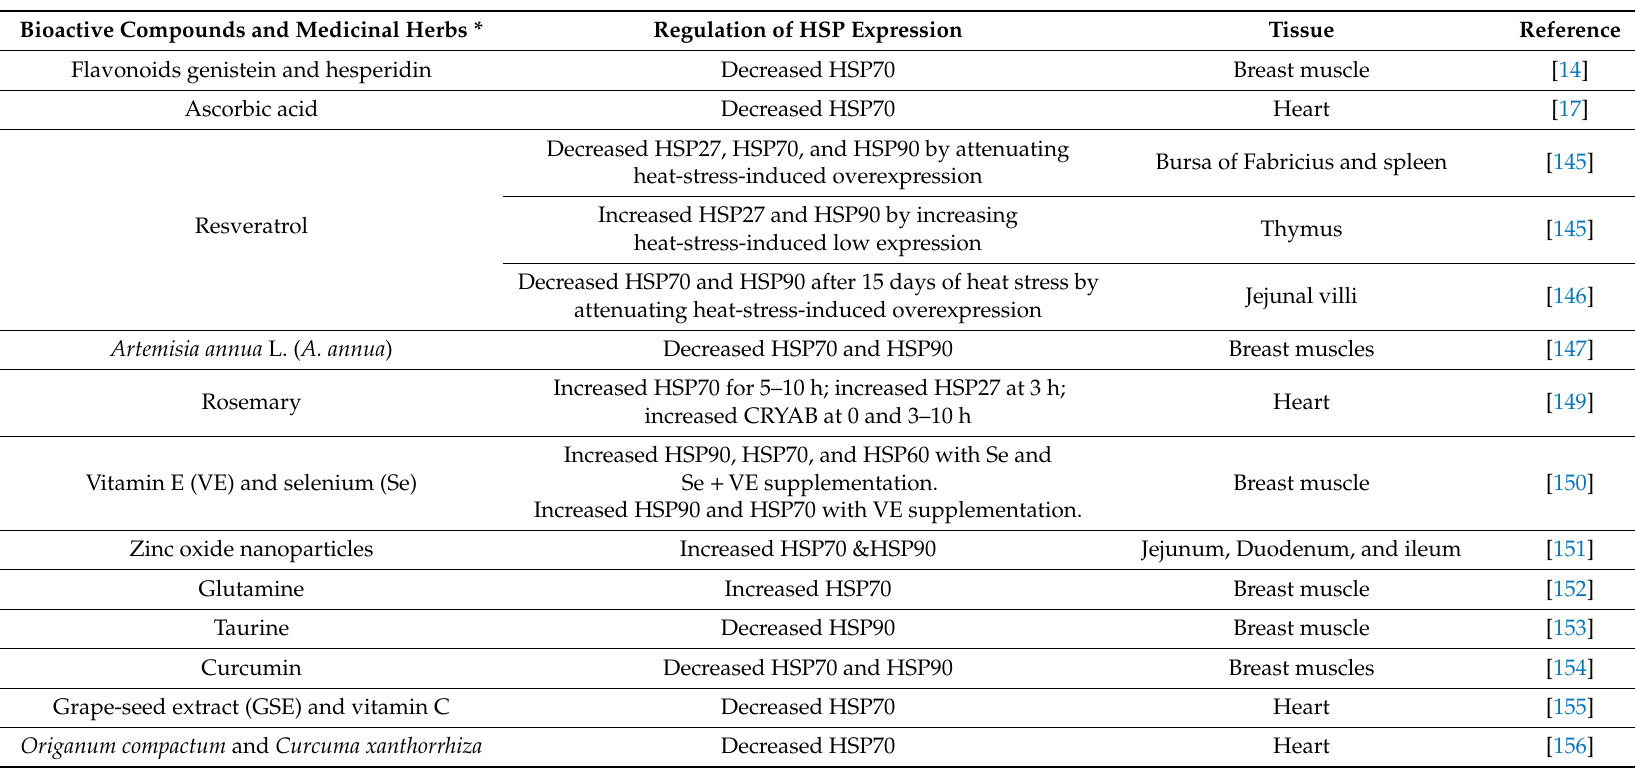
Table 1. E ff ect of nutritional and pharmacological compounds on heat-shock proteins (HSPs) expression in heat-stressed chicken. Bioactive Compounds and Medicinal Herbs